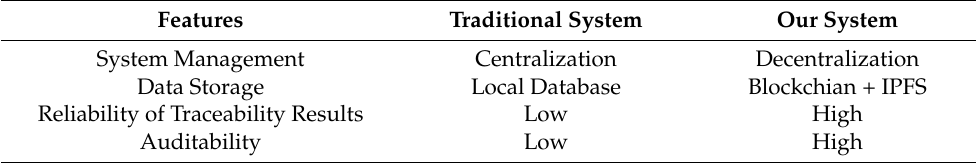
Table 10. Comparison with Traditional Agricultural Traceability